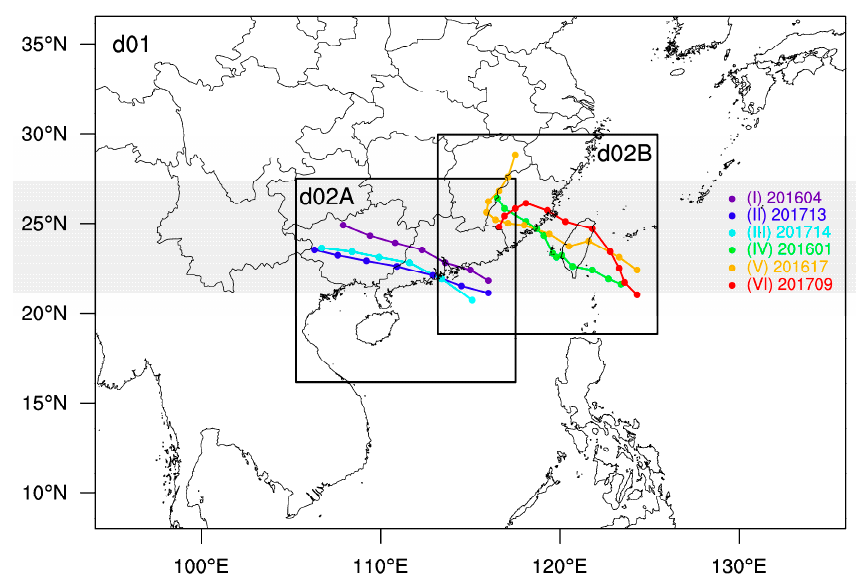
Figure 13. The same study domain as Figure 1, but with six observed typhoon tracks from 2016 and 2017. The d02A and d02B includes 3-days typhoon tracks of events (I) − (III) and events (IV) − (VI) respectively. Table 3. Typhoon validation events from 2016 and 2017.